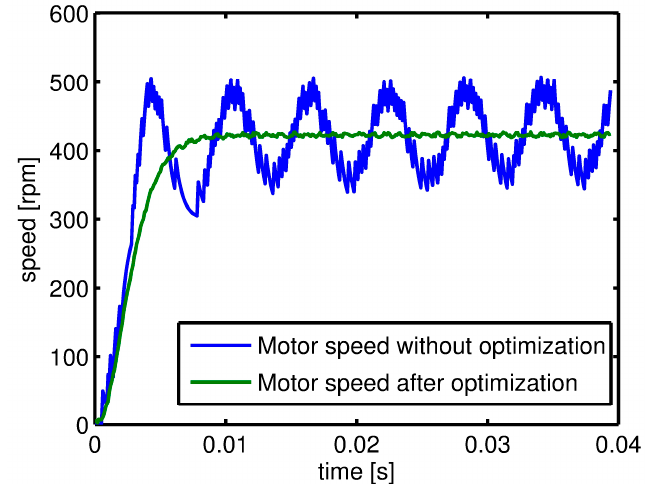
Figure 14. Motor speed without and after optimization.